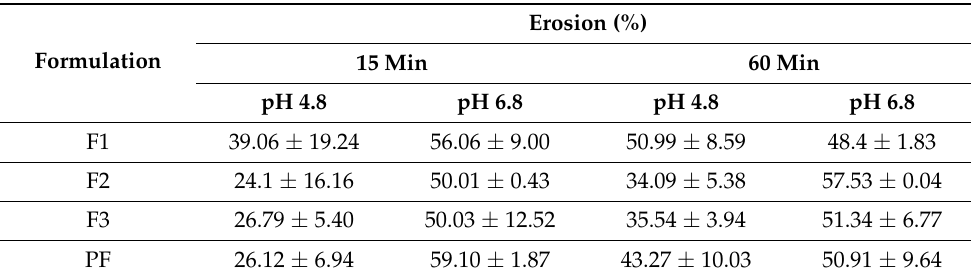
Table 5. Percentage of erosion of the films F1–F3 and the placebo films PF after 15 and 60 min at different pH conditions (mean ± SD, n = 3).